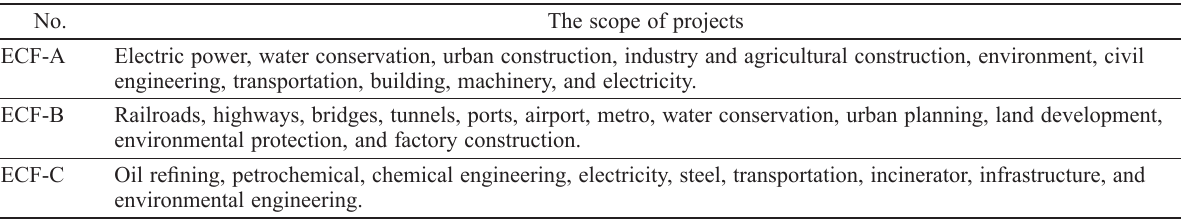
Table 1. The scope of projects undertaken by engineering consulting firms in case study No.